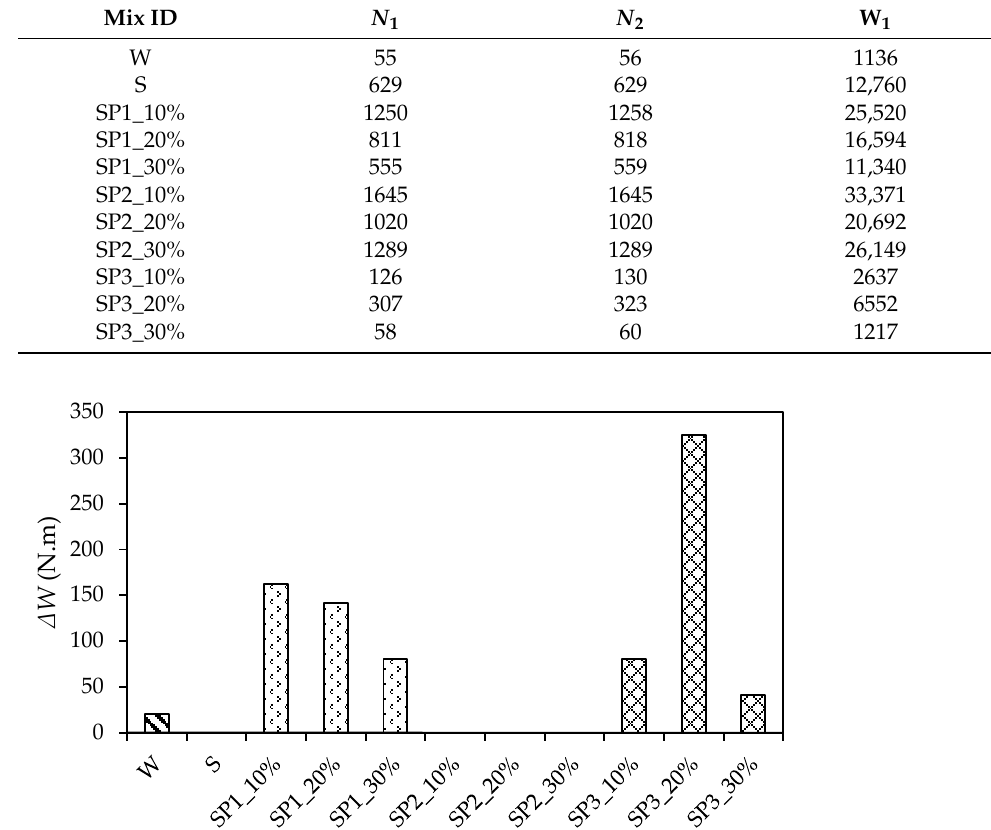
Table 6. Test data of Impact Resistance.